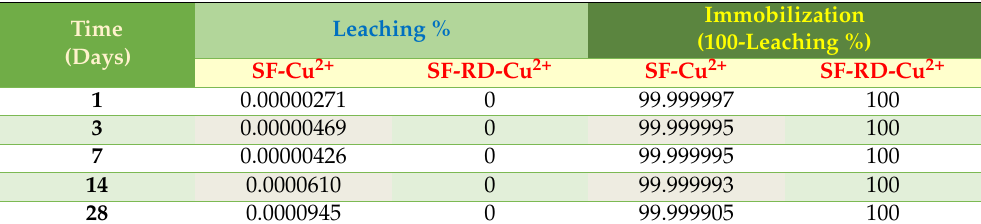
Table 5. Leaching % and immobilization values of copper (II) ions (700 ppm) in leachate solutions of different geopolymer mixes after different curing times.